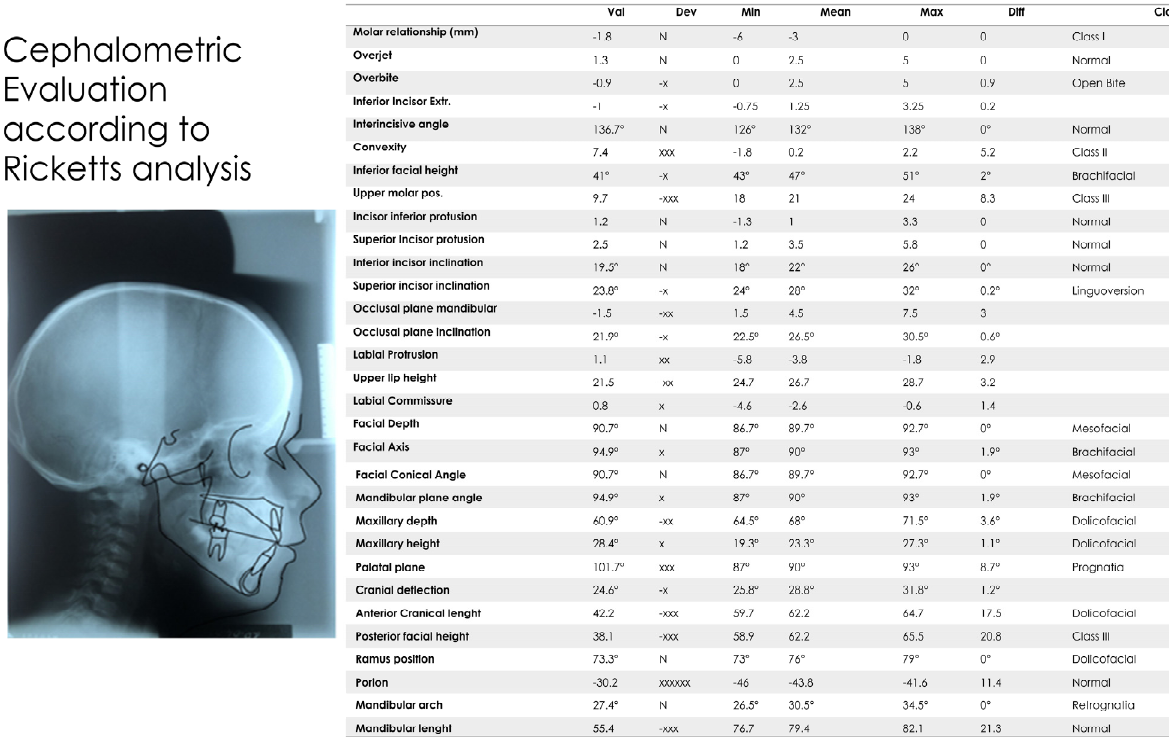
Figure 5. Ricketts analysis (Deltadent ® , Outside Format- Pavia Italy) 10 April 2008.